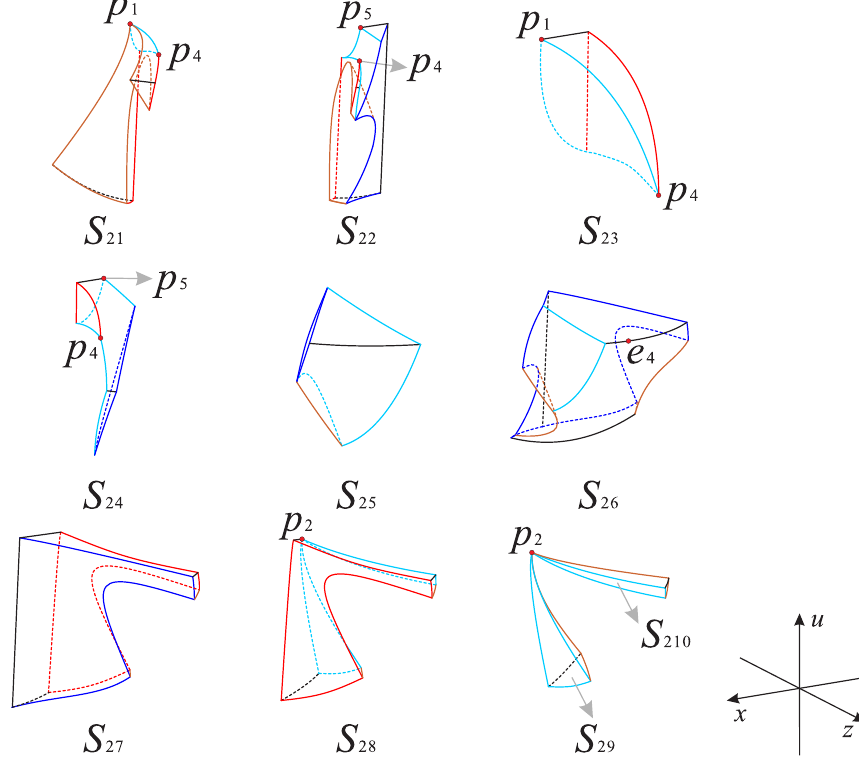
Figure 26. The ten subregions inside the region S 2 of the Poincaré ball. As shown in Figure 25, the top surface of the subregion S 11 is contained in the Poincaré sphere; the bottom surface is contained in the surfaces h 1 = 0 and h 2 = 0; the bottom plane is contained in the invariant plane u = 0; the left and right sides are contained